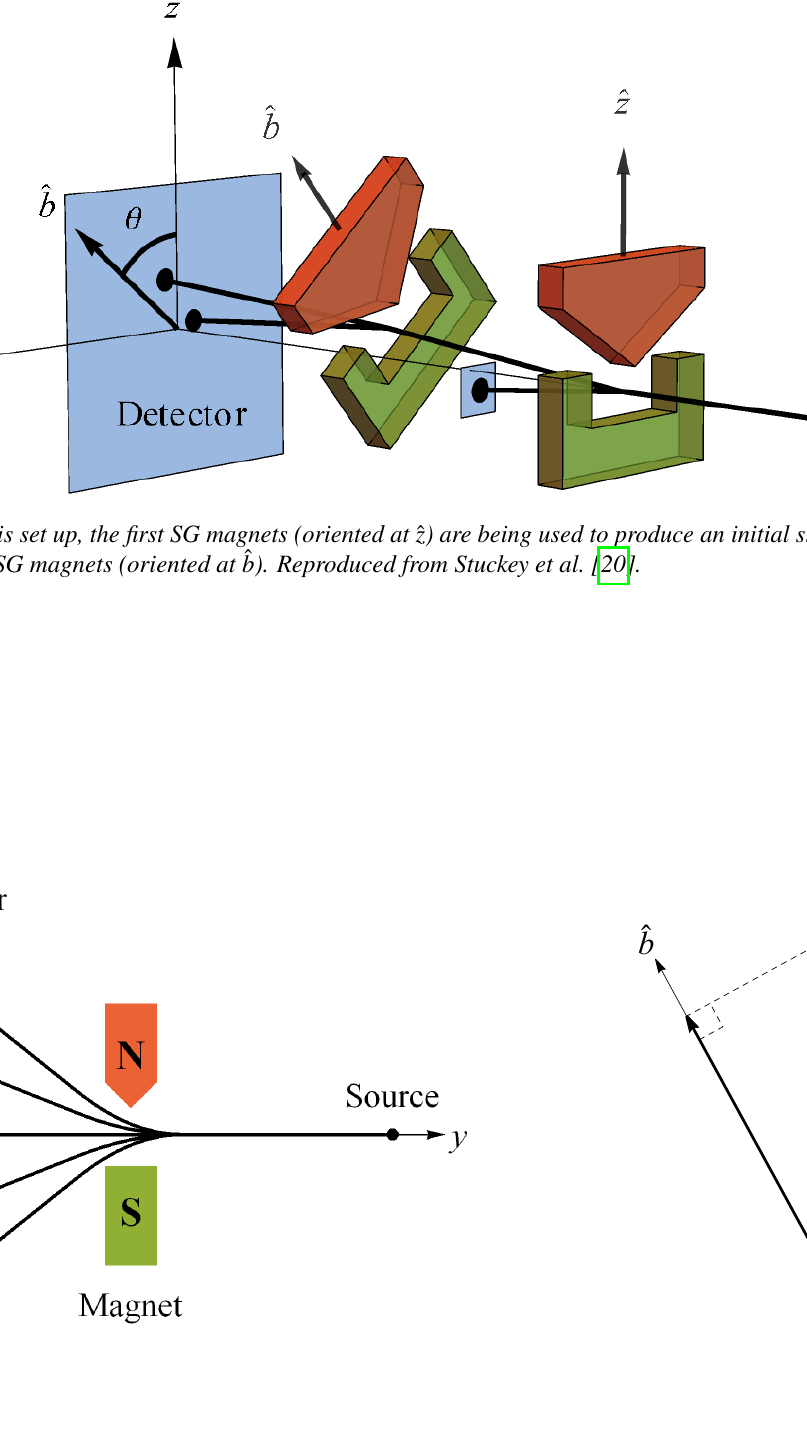
Figure 4: The classical constructive model of the Stern– Gerlach (SG) experiment. If the atoms enter with random orientations of their “intrinsic” magnetic moments, the SG magnets should produce all possible deflections, not just the two that are observed [2, 25]. Reproduced from Stuckey et al. [20].